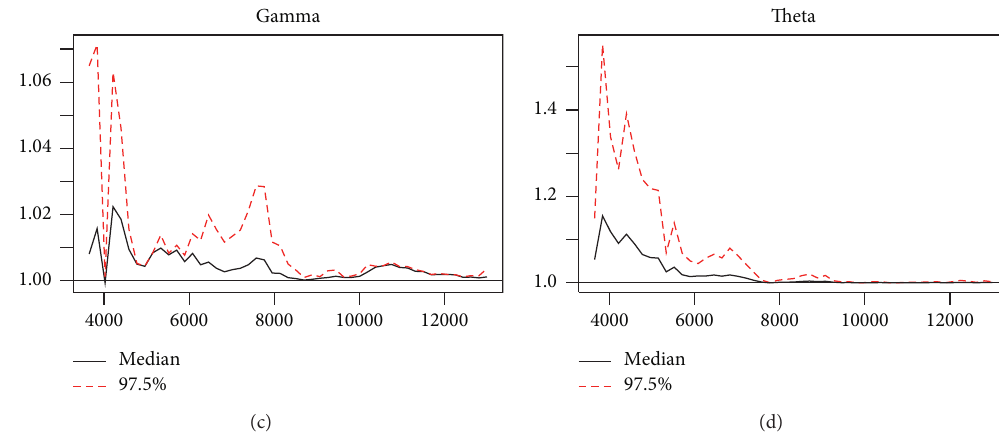
Figure 16: Gelman plot diagnostic for each parameter of NGE-Weibull distribution based on the failure time data.